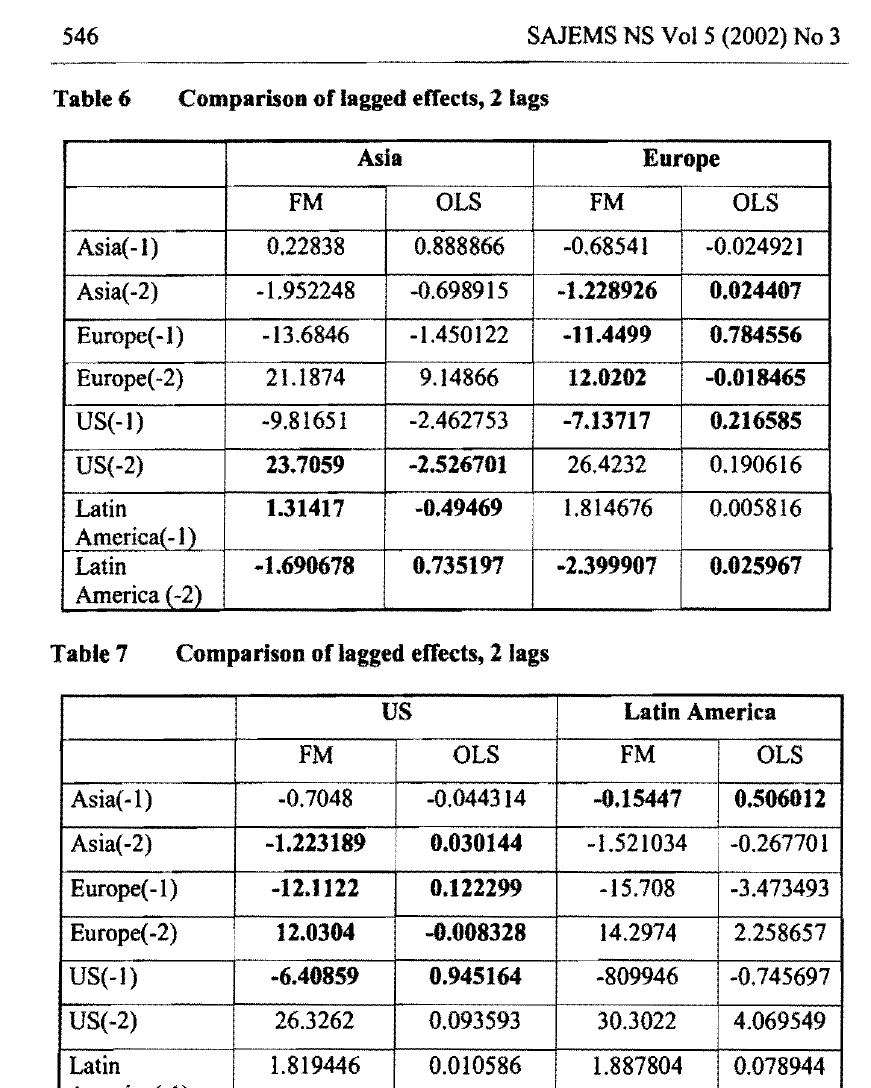
Comparison of lagged effects, 2 lags